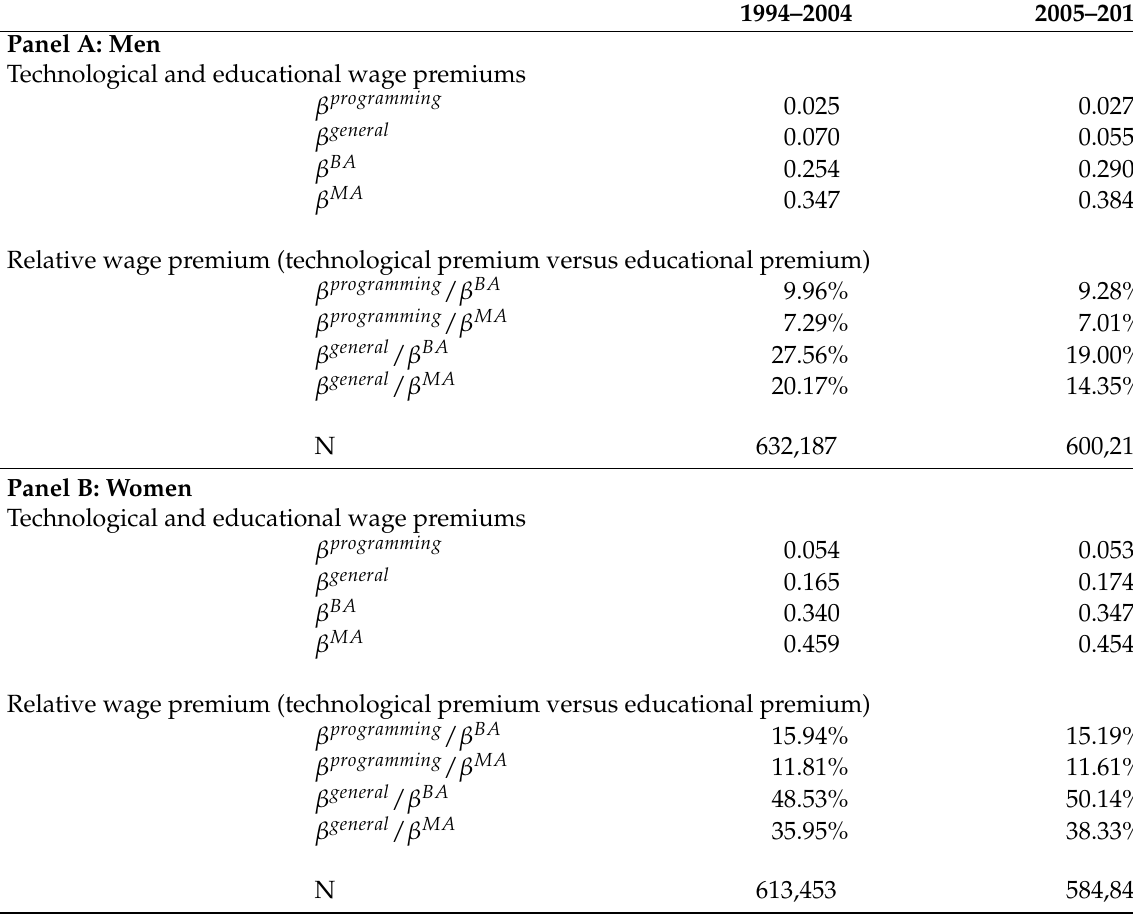
Table 3: Comparison of technological and educational wage